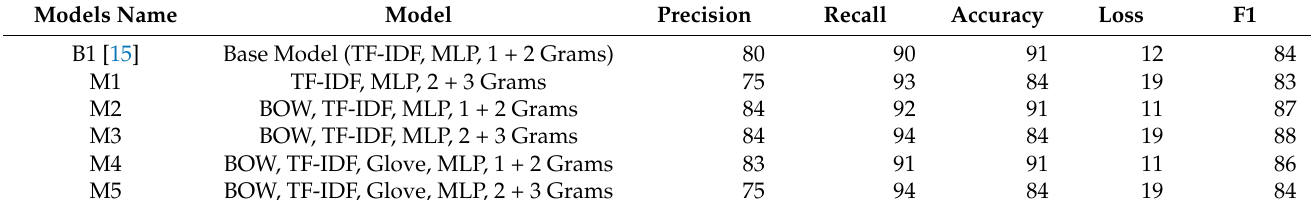
Table 3. Evaluation Table Proposed Model vs. Sadiq, S (2021) Model.